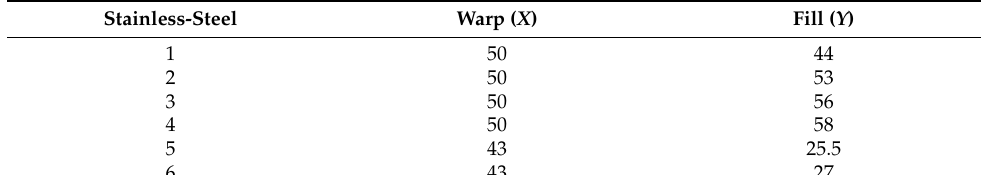
Table 4. Sizes of each SST.